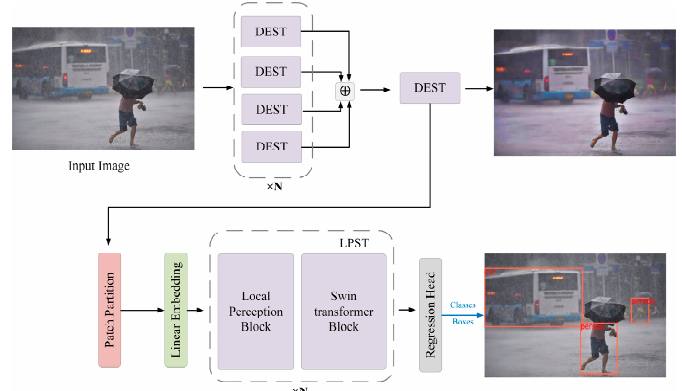
Figure 1. The overall architecture of pedestrian and vehicle detection on rainy days. The new network could accurately complete the task of rainy image object detection and image deraining.